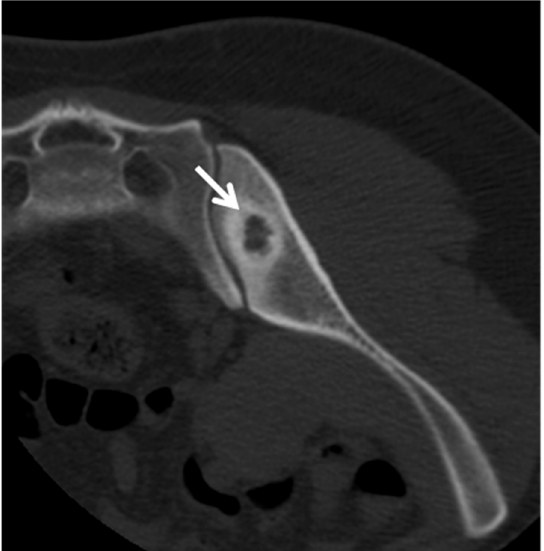
Figure 4. Brodie’s abscess in a 30-year-old man. Computed tomography of the pelvis showed a small (1.5 cm) radiolucent lesion with thick and irregular sclerotic margins (arrow). Magnetic Resonance Imaging. Brodie’s abscess is visible on MRI as a so-called “target sign”, which is formed by four concentric layers of tissue (necrotic tissue at the center, encircled by an adjacent deposit of granulation tissue, and sclerotic or fibrotic tissue with an outermost rim of edema). Starting centrally and moving outward, this results in T1- weighted sequences in a pattern of low signal (necrosis), intermediate (isointense to muscle) signal (granulation tissue), very low signal (sclerotic or fibrotic tissue), and low